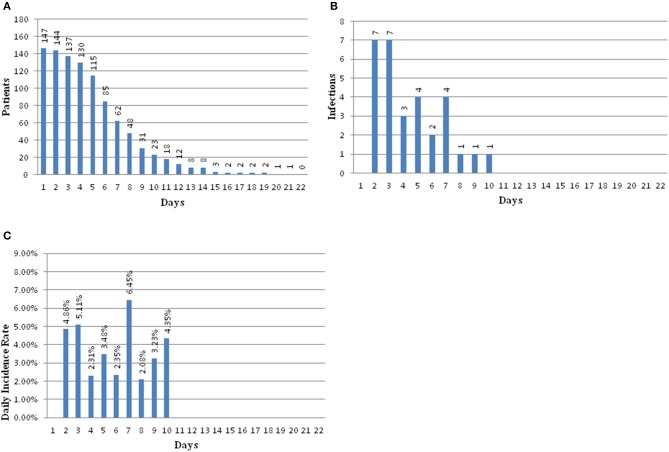
(A) Bar graph showing patients at risk for infection over time. (B) Bar graph showing number of infections over time. (C) Bar graph showing the daily infection rate over time.